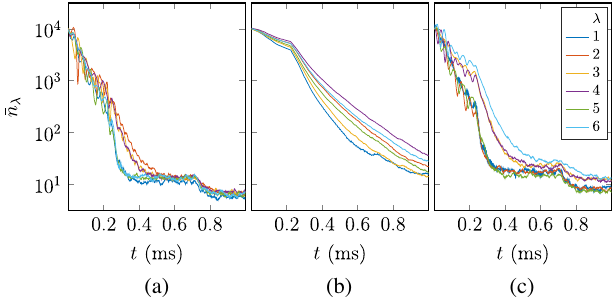
FIG. 3. Mode occupation numbers as a function of time for a six- 9 Be þ -ion honeycomb lattice being laser cooled in conjunction with axialization. (a) Cyclotron (b) Axial (c)